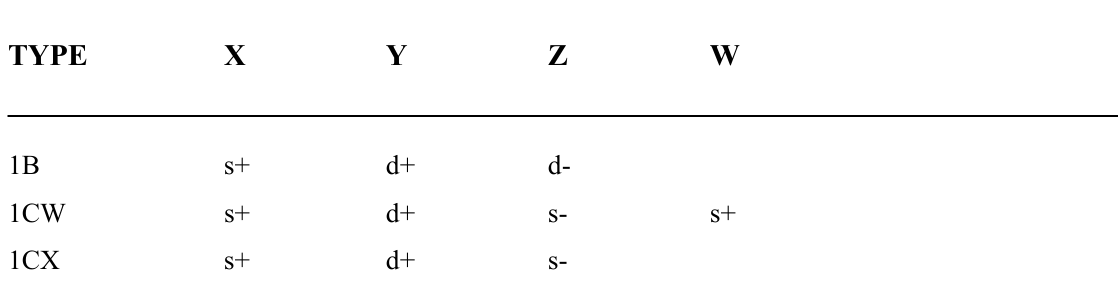
Autocatalysis, Regulation, and Stability in Critical